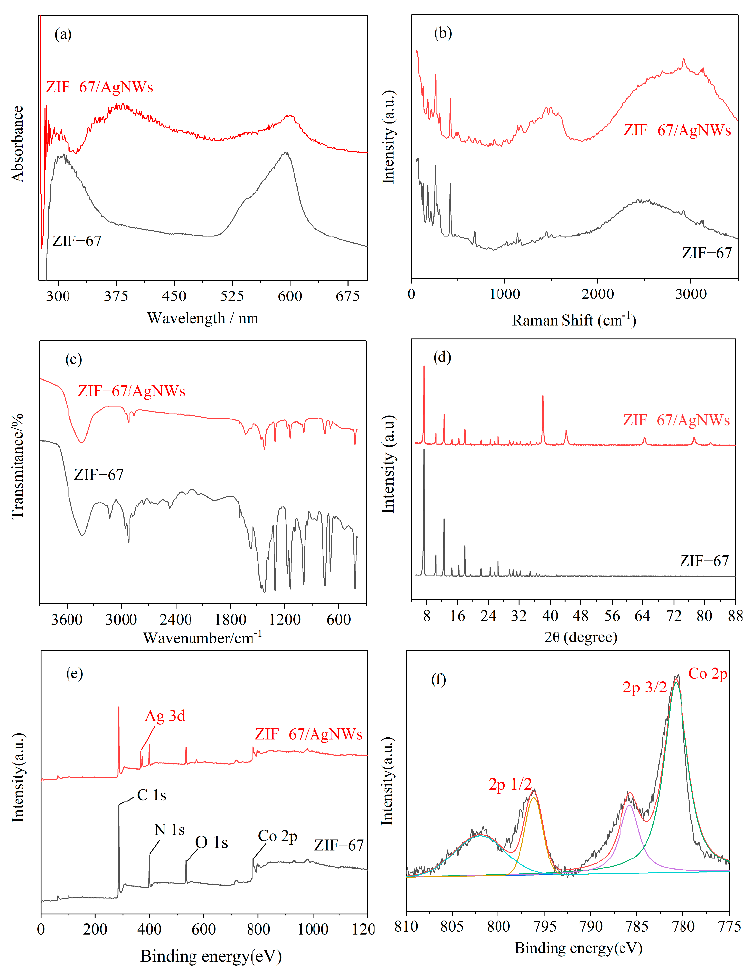
Figure 2. ( a ) UV − vis spectra, ( b ) Raman spectra, ( c ) FT–IR spectra, ( d ) XRD patterns, and ( e ) full-scan XPS spectra of ZIF − 67 and ZIF − 67/AgNWs. ( f ) High-resolution XPS spectrum of Co 2p.